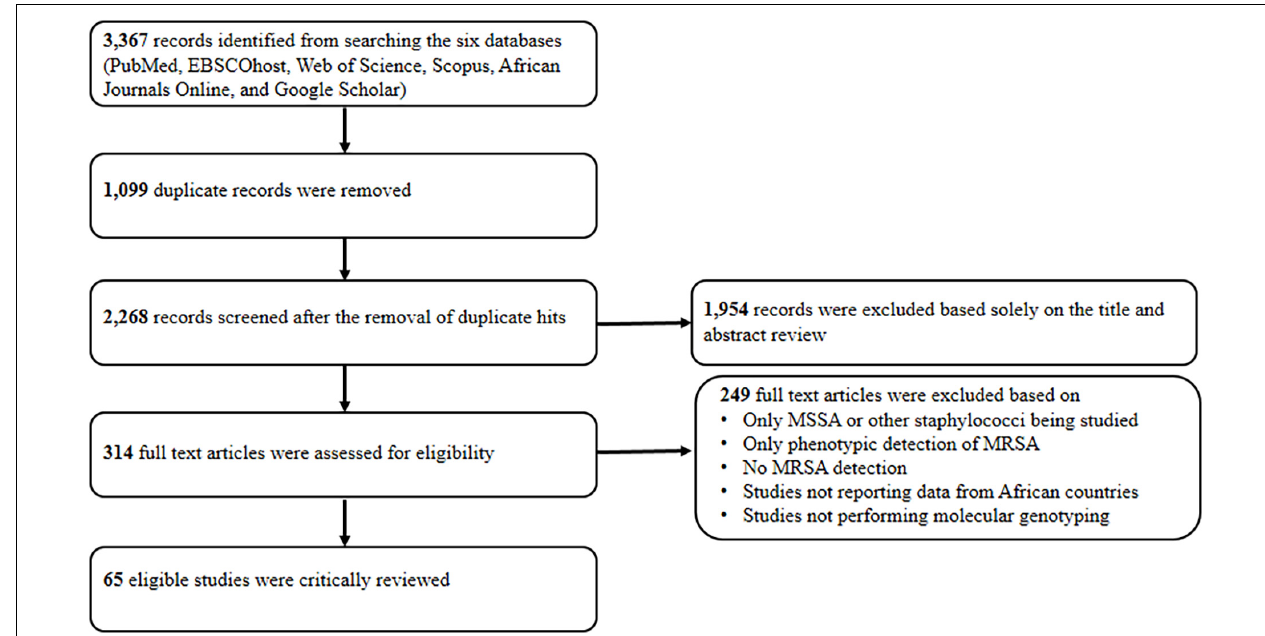
FIGURE 1 | Standard preferred reporting item for systematic reviews. MSSA, methicillin susceptible Staphylococcus aureus ; MRSA, methicillin-resistant Staphylococcus aureus .